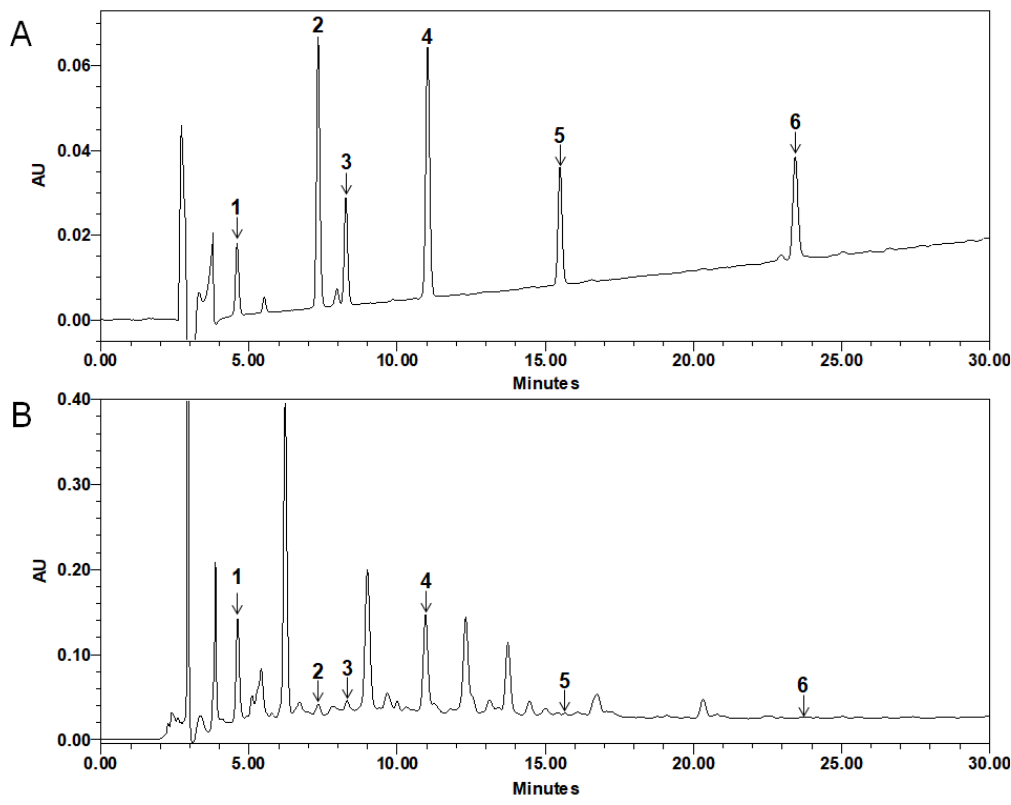
Figure 6. HPLC chromatogram of standard solution ( A ) and PMB ( B ) at 240 nm. 1; chlorogenic acid (retention time (RT) = 4.61 min), 2; caffeic acid (RT = 7.33 min), 3; rutin (RT = 8.30 min), 4; Genistein 7- O - β -glucopyranoside (G7G, RT = 10.96 min), 5; prunetin 5- O - β -glucopyranoside (P5G, RT = 15.66 min), 6; luteolin (RT = 23.65 min).